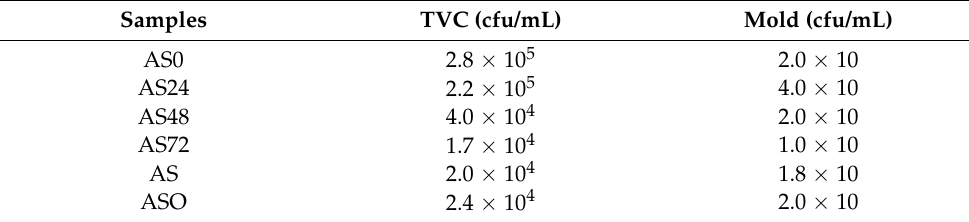
Table 6. Effect of SSF on the microbial count of the complementary food (wet